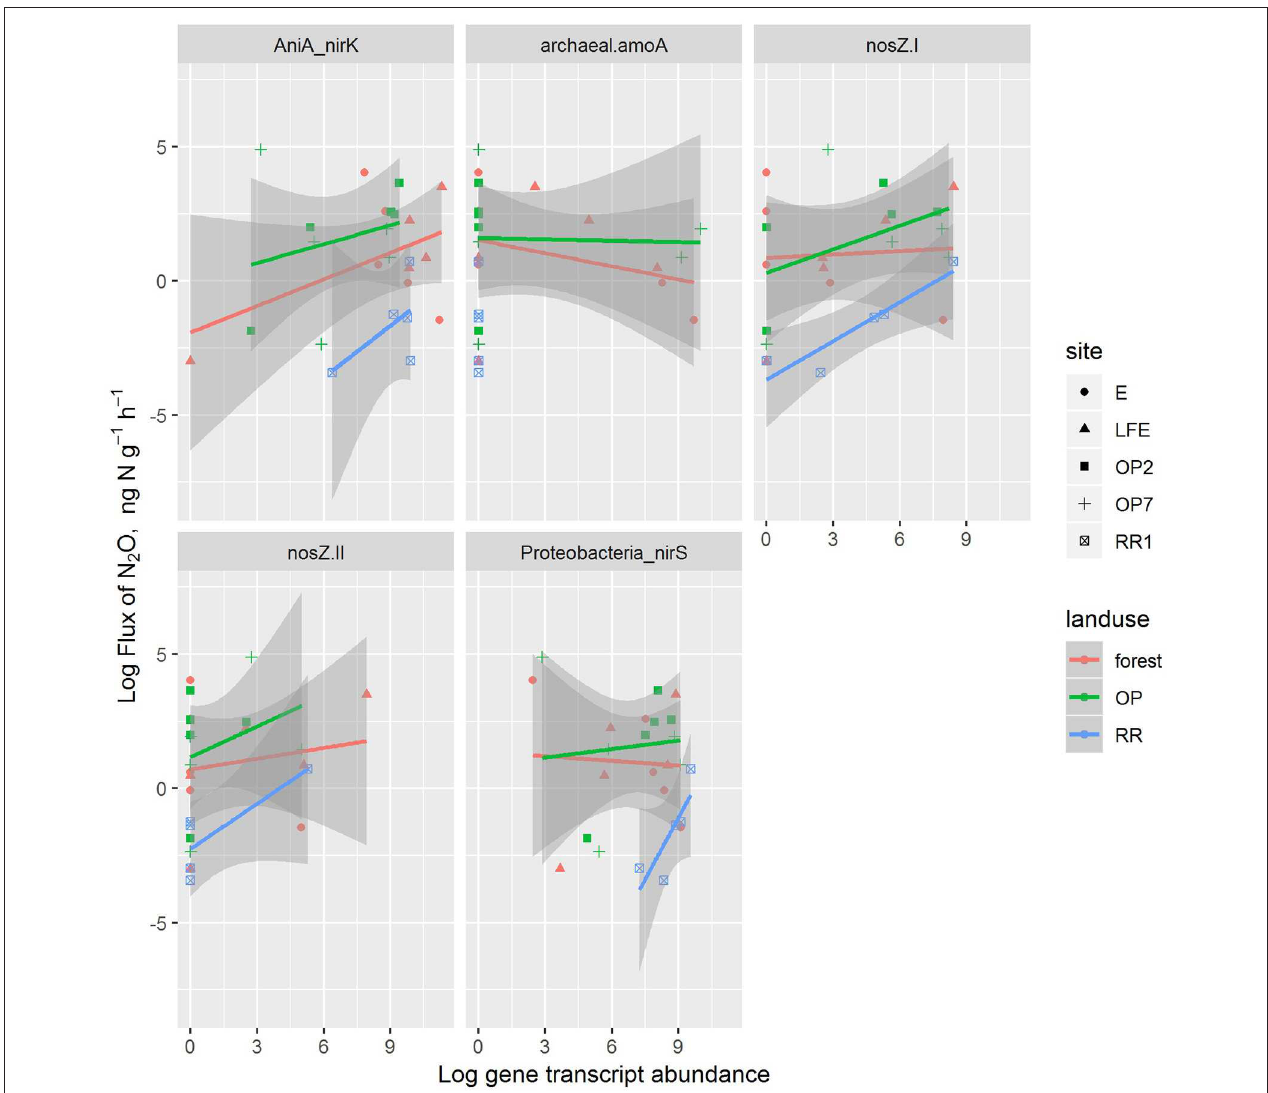
FIGURE 4 | The correlations between N 2 O fluxes with and transcript abundances of denitrifier and nitrifier genes in different land-use soils [red: oil palm (OP), green: logged forest (forest), blue: riparian reserve (RR)]. For site identification, E and LFE are logged forest, OP2 and OP7 are oil palm plantations and RR1 is riparian